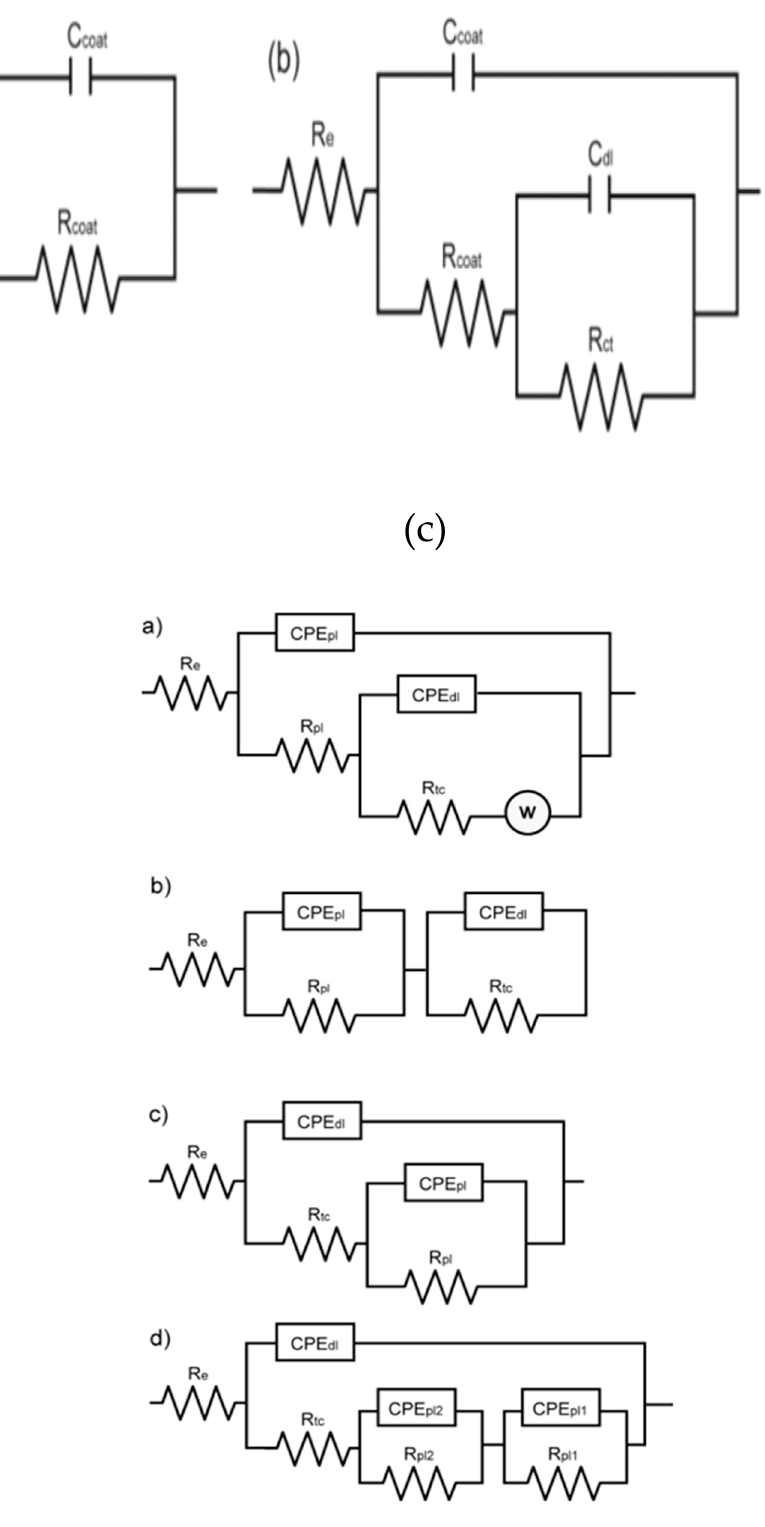
Figure 4. ( a ) EC showing an ideal metal-coating system; ( b ) a damaged coating; and ( c ) di ff erent EC schemes proposed to represent archaeological copper alloys. Reproduced and reprinted with permission from [41]